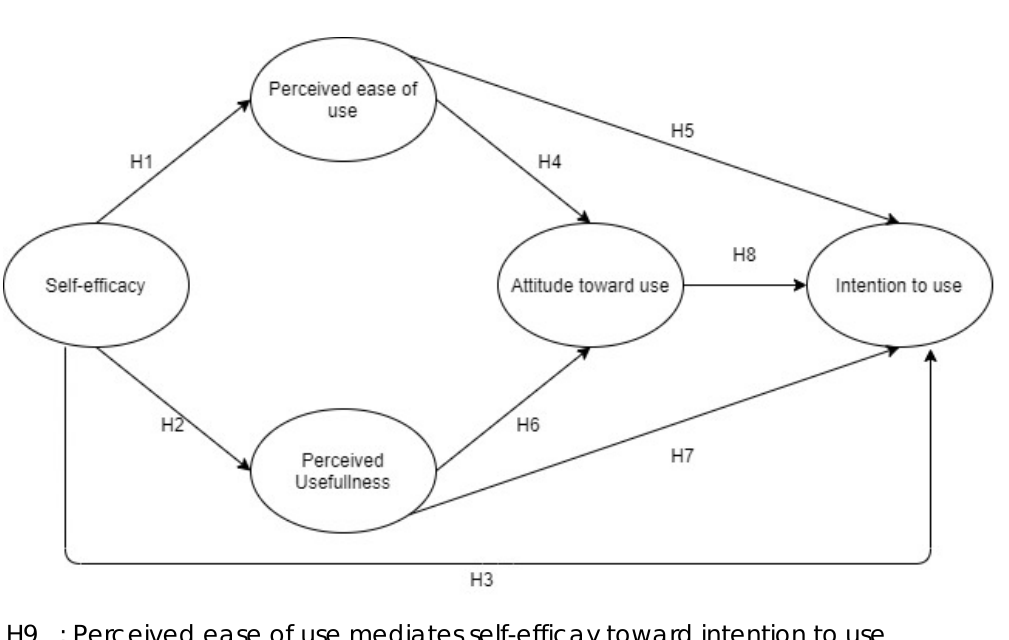
Figure 1. Conceptual